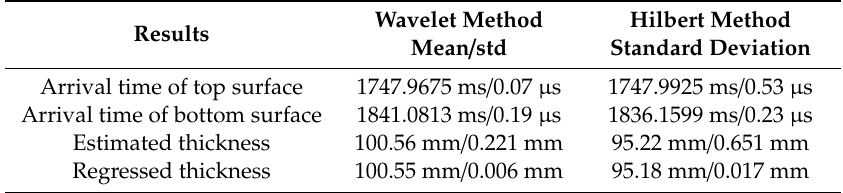
Table 3. Quantitative comparison of the results with di ff erent methods.